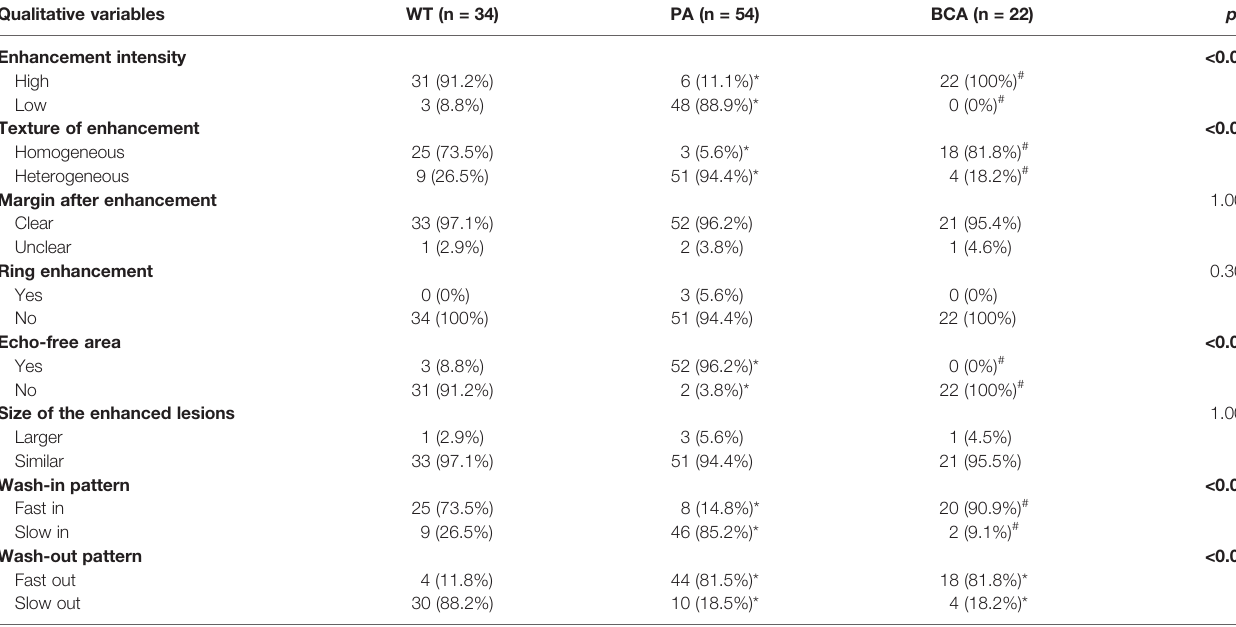
TABLE 3 | The real-time dynamic results and qualitative analysis of contrast-enhanced ultrasonography (CEUS) in common benign parotid gland tumors (n = 110). Qualitative